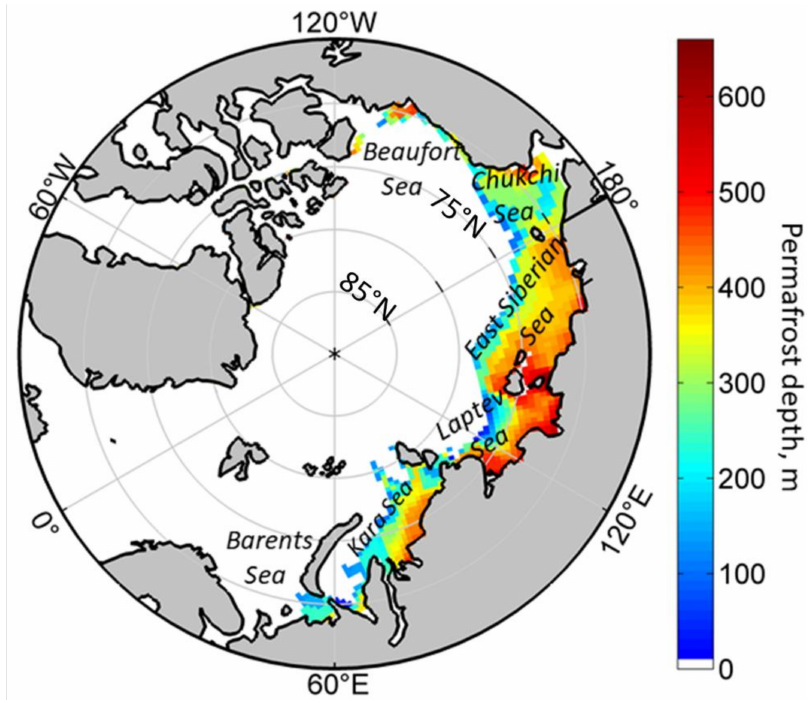
Figure 1. The distribution and the depth of the modeled submarine permafrost beneath the Arctic Ocean Shelf seas (modified after [14,19]). The diffusion methane flux from the bottom to water is 30 mg/m 2 per day in colored ocean